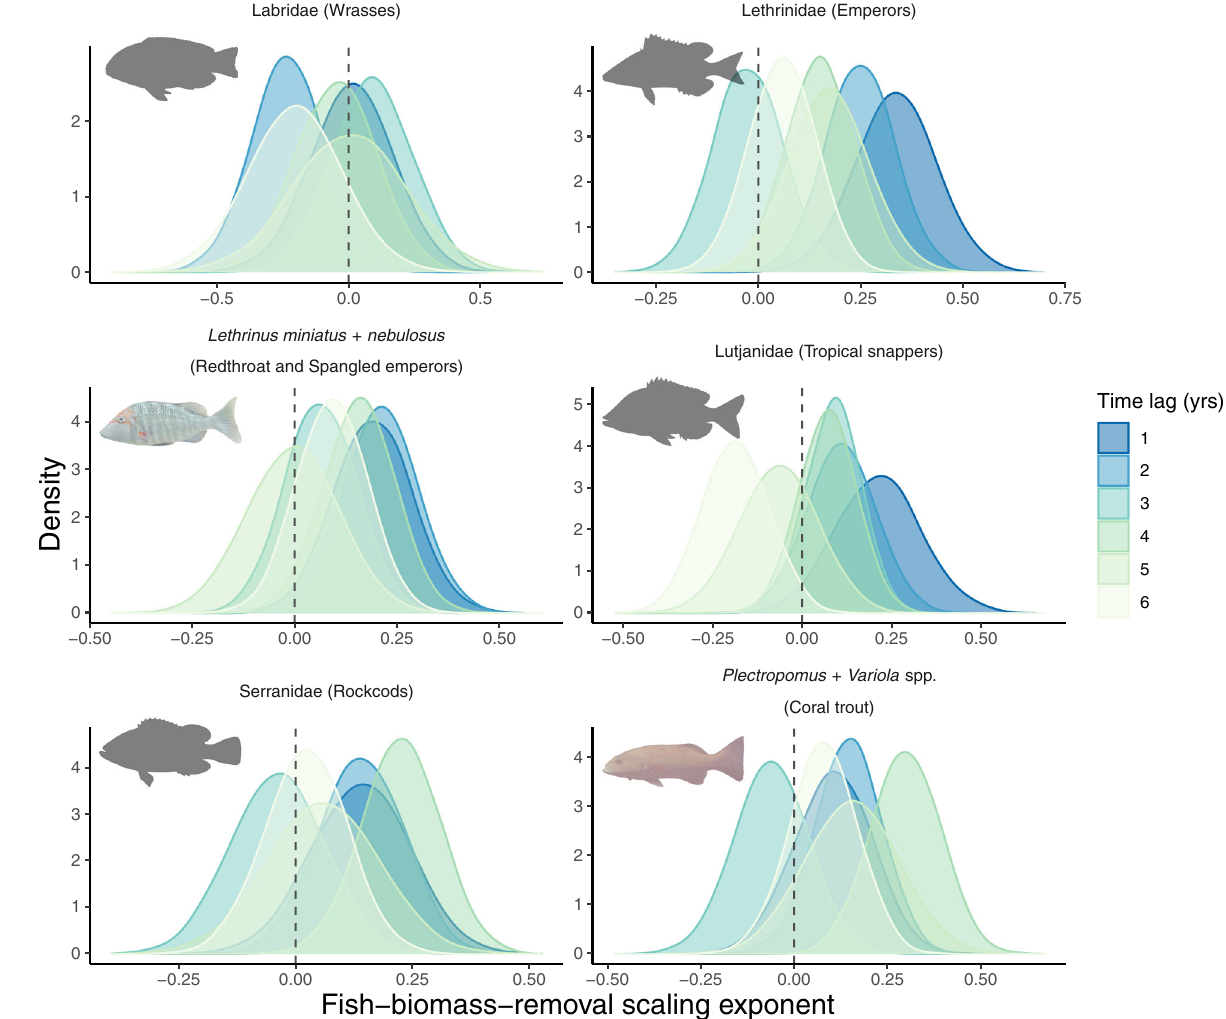
Fig. 1 Response of Crown-of-Thorns Star fi sh density to fi sh biomass removal. Posterior distributions of the biomass-removal scaling exponent of Paci fi c Crown-of-Thorns Star fi sh (CoTS, Acanthaster cf. solaris ) density. For each target fi sh group and time lag, the exponent was estimated independently using a hurdle-gamma Bayesian model (see “ Methods ” ; Supplementary Method 2). Exponents are equivalent to the fi sh biomass-removal slope on the linear scale (log) of the gamma (i.e. non-zero) component of the model. Vertical dashed lines represent zero, and values above this line constitute evidence suggesting that fi sh biomass removal drives increase in CoTS density over time. Source data are provided as a Source data fi le. Fish silhouettes for Lethrinidae, Serranidae and L. miniatus from AIMS ©, for P. leopardus from F. Kroon ©, for Lutjanidae from R package fi shualize (https://github.com/nschiett/ fi shualize, License GPL-2) and for Labridae cut and adapted to a silhouette from Fig. 2C ( Choerodon anchorago , terminal phase male) in Gomon 63